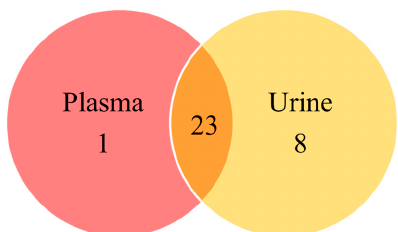
Figure 5. Venn diagram illustrating metabolites found exclusively in plasma (1), exclusively in urine (8) and in both matrices (23). (8) and in both matrices (23) .